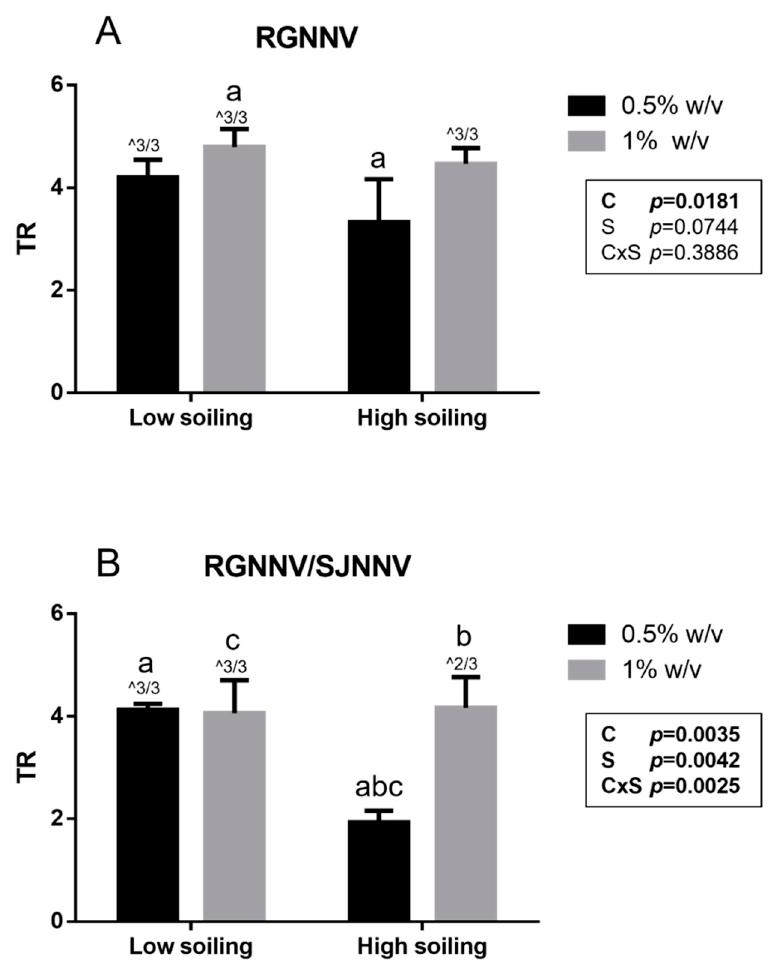
Figure 1. Suspension test results obtained for the RGNNV strain ( A ) and the reassortant RGNNV/SJNNV strain ( B ). TR: titer reduction; C: disinfectant concentration; S: soiling level. The same superscript letters indicate significant differences among titer reduction values ( p ≤ 0.05). ^ indicates the number of test repeats where no CPE was detected.